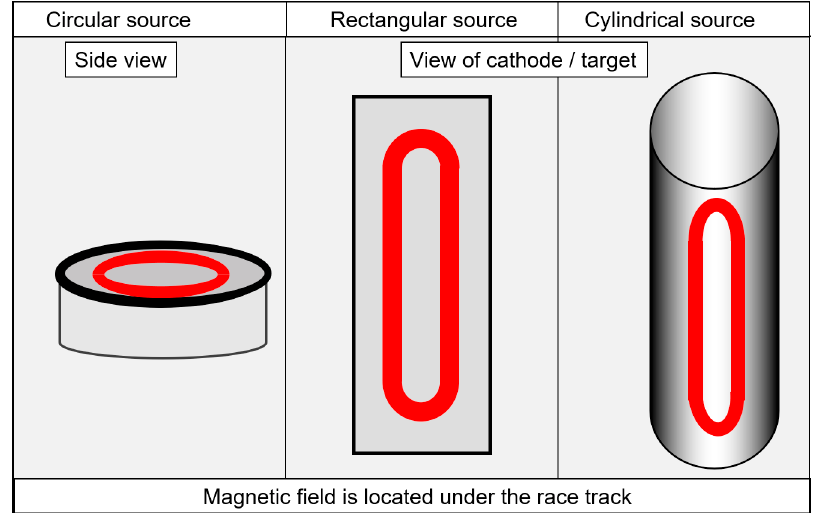
Figure 1. Schematic drawing of the circular, rectangular or tubular active evaporation surfaces, redrawn after [27], original © Vulkan-Verlag,